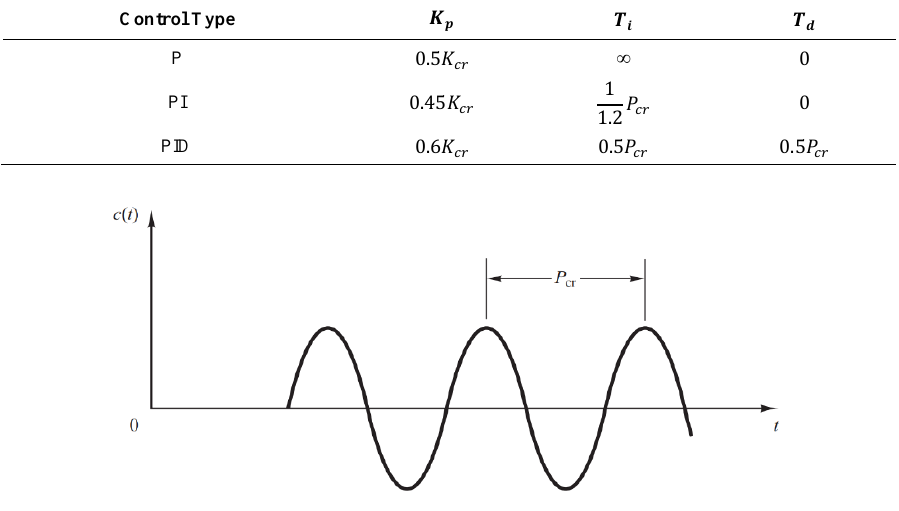
Figure 5. The oscillating